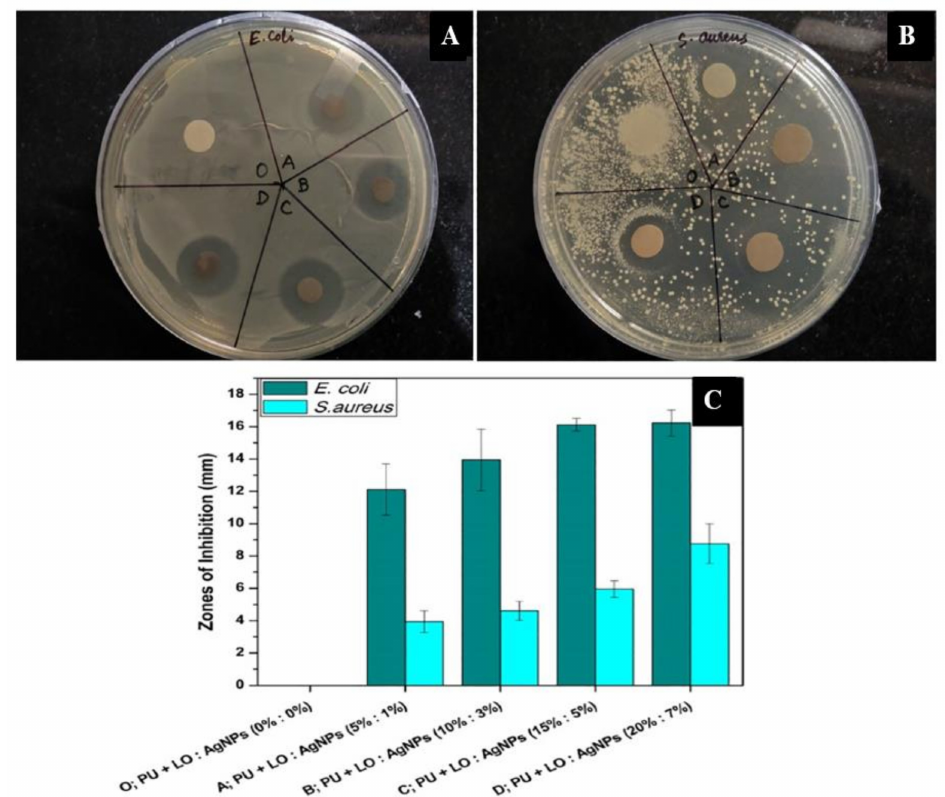
Figure 6. ( A , B ) Images of agar plates containing nanofibers with varying concentrations of LO and Ag NPs tested against Escherichia coli and Staphylococcus aureus . ( C ) Inhibition areas of nanofiber mats and composites were tested by disk-diffusion assay against the above strains, reproduced from [107] with copyright permission from